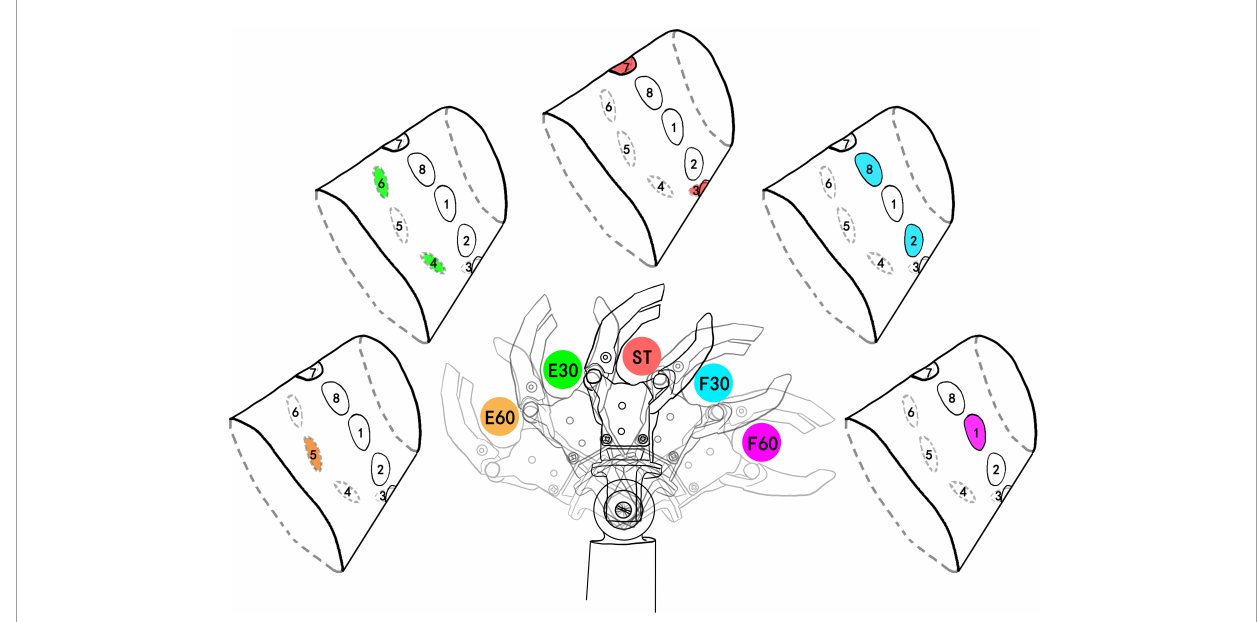
FIGURE2 Five wrist FE (flexion and extension) positions and corresponding stimulating channels. The colored channel represents the active (under stimulating) channel. E60, extension 60 ◦ ; E30, extension 30 ◦ ; ST, straight 0 ◦ ; F30, flexion 30 ◦ ; F60, flexion 60 ◦ . E60 and F60 are limit positions of prosthetic wrist and they are coded by single channel. ST was defined as the initial position. The number after F and E was defined as the angle deviating from the ST position. The colors of active channels are consistent with the stimulation mode.